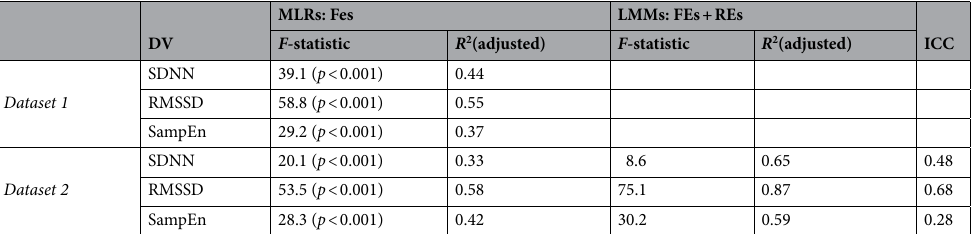
Table 4. The statistics for both the MLR and LLM models, which incorporate FEs and FEs + REs, respectively. The F-statistic, R 2 (adjusted), and, where applicable, ICC are reported for each DV in both datasets. DV